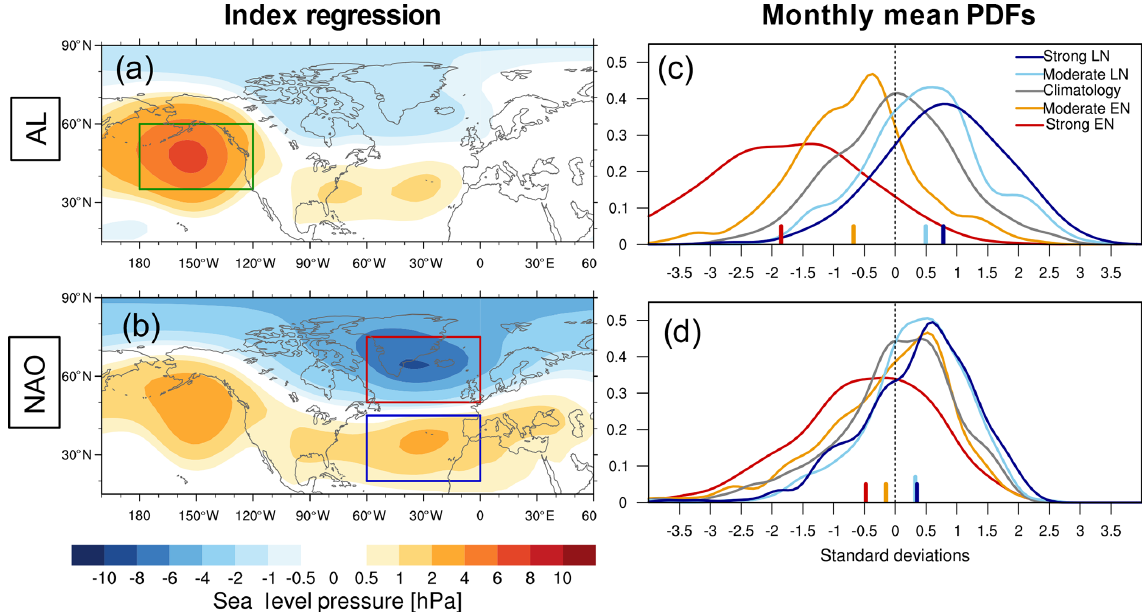
Figure 7. December to March monthly SLP (in hPa) regressed onto (a) the AL and (b) the NAO indices, using the five simulations with stratospheric nudging (396 years). Green, red, and blue boxes indicate the regions used to define the AL and NAO indices; see main text for details. The PDFs of the December–January–February–March standardized monthly means for (c) the AL and (d) the NAO indices. Colors represent the PDFs for the different ENSO forcings (red: strong EN, orange: moderate EN, grey: climatology, light blue: moderate LN, dark blue: strong